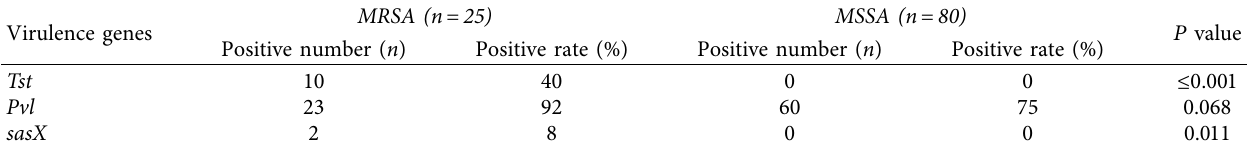
Table 3: Comparison of virulence gene carrying between MRSA and